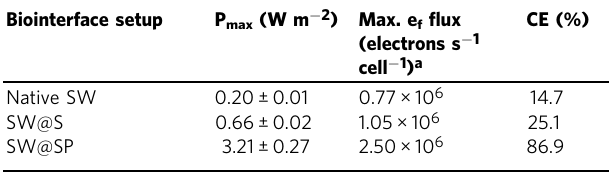
(Table 1). More surprisingly, the single cell electron transfer rate